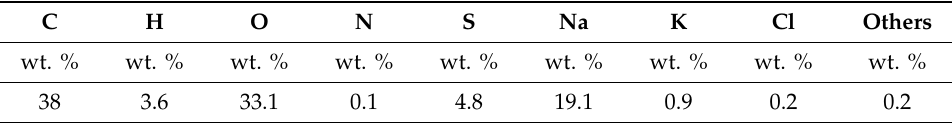
Table 2. Elemental composition of dry pine black liquor (dry matter basis). Data is taken from Al é n and Niemelä [37].